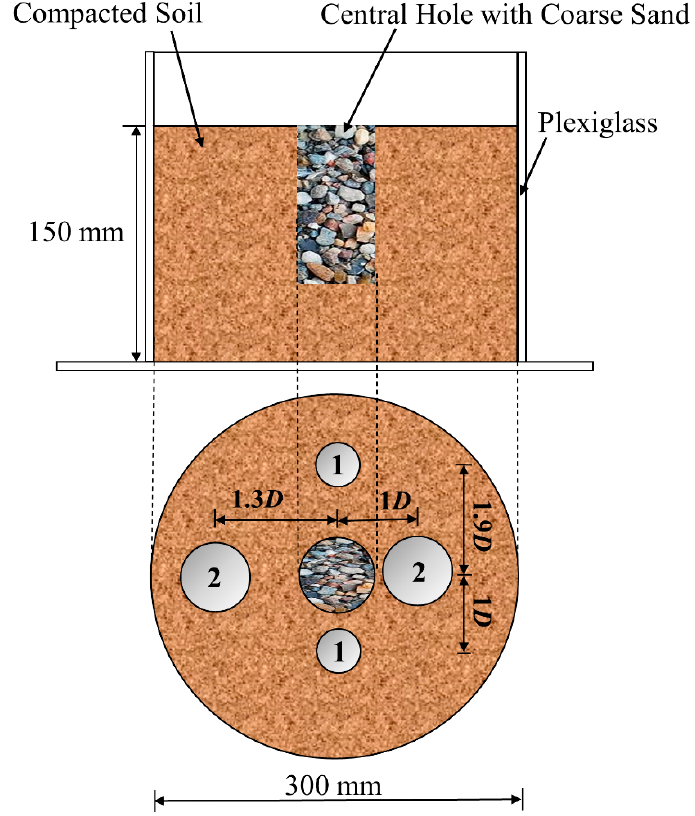
Figure 3. The laboratory-scale model test mold ( D : diameter of central hole, 70 mm).